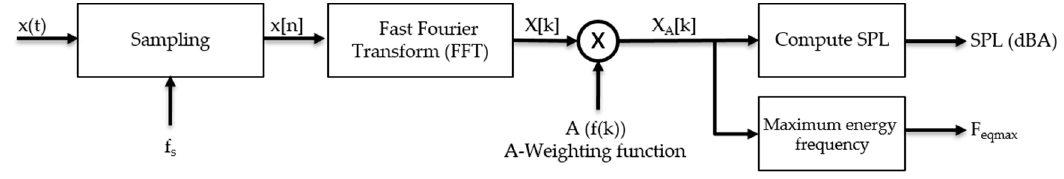
Figure 4. The algorithm’s functional blocks. SPL—sound pressure level.